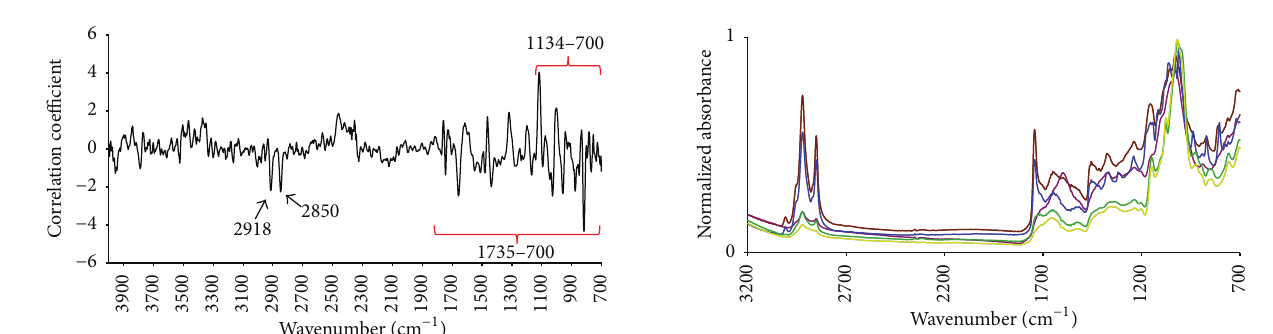
Figure 1: Full-spectrum regression coefficients (4000–700 cm −1 ) of the PLS model based on the data submitted to SNV followed by mean centering.